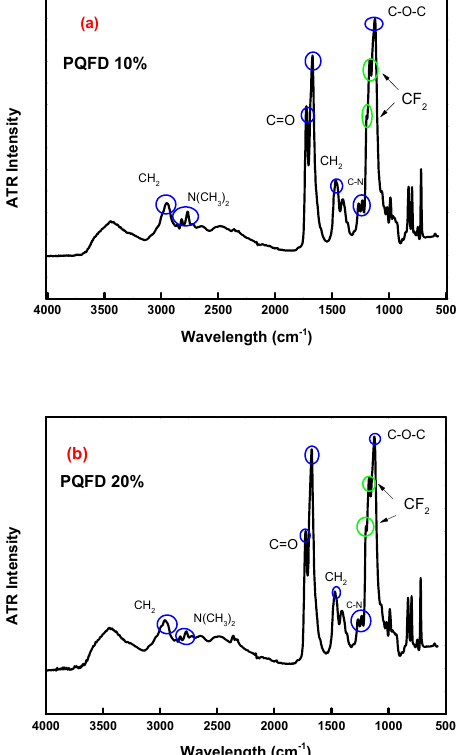
Figure 2. 1 H − NMR spectra of the ( a ) quaternized PQFD 10% and ( b ) quaternized PQFD 20%am- phiphilic copolymers. The peak at 7.2 ppm (*) is assigned to the solvent protons.